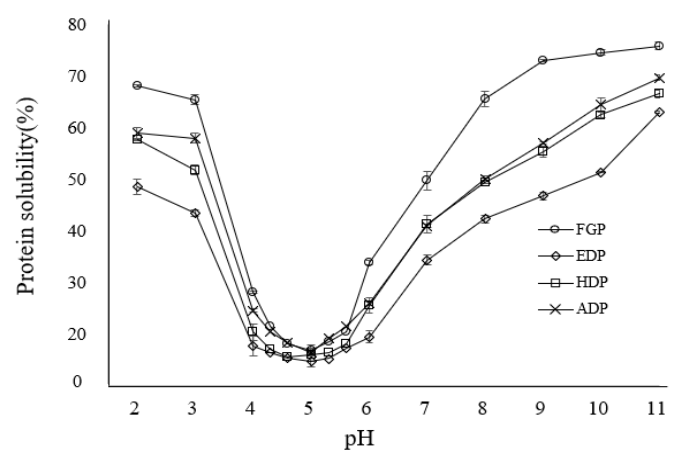
Figure 1. Protein solubility of G. bimaculatus and three defatted protein concentrates at different pH values. FGP, freeze-dried Gryllus bimaculatus powder; EDP, ethanol-defatted protein concentrate; HDP, hexene-defatted protein concentrate; ADP, acetone-defatted protein concentrate.